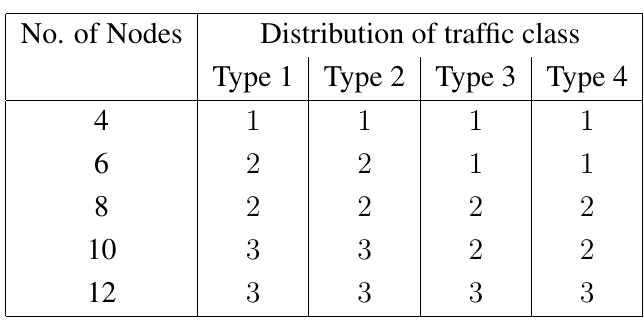
Table 4. Traffic class distribution varying network